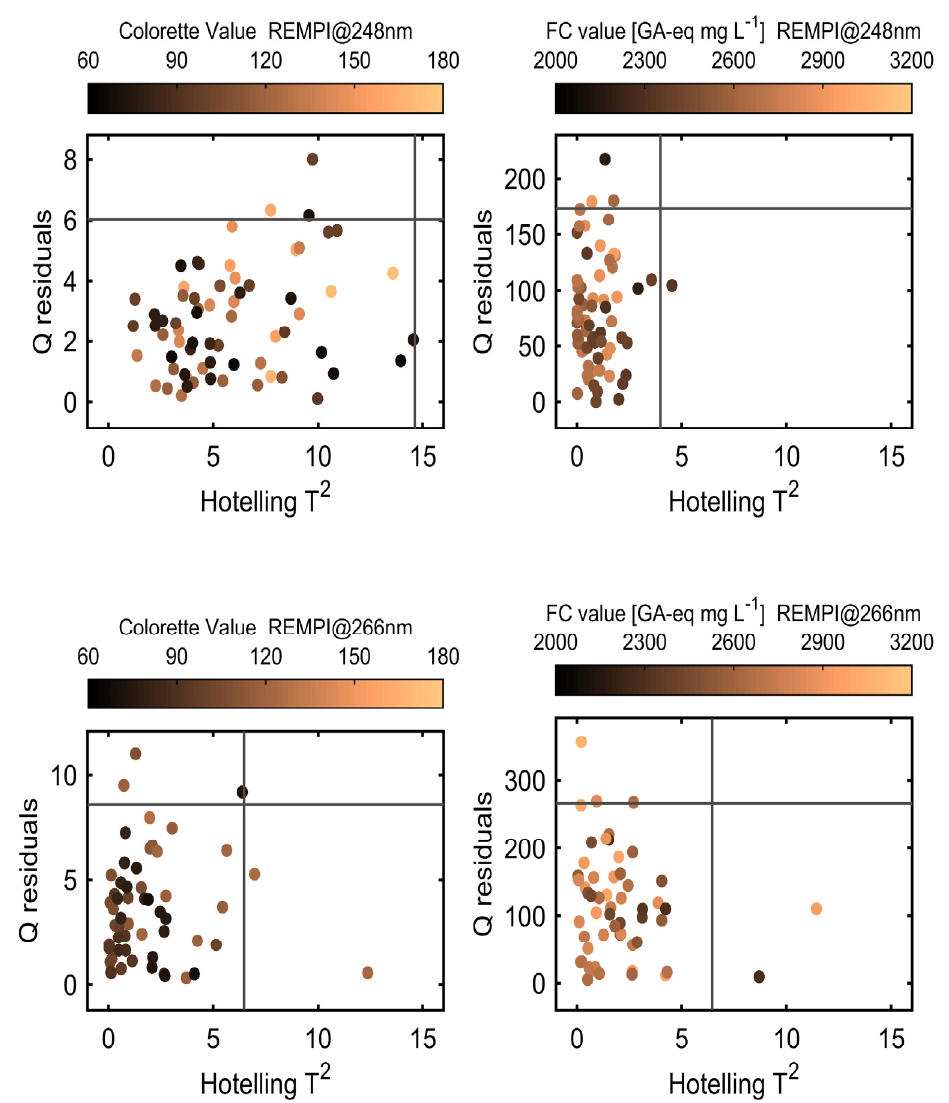
Figure A5. T 2 -Q diagnostic plots for outlier identification of samples in the calibration (training) data set. Larger Q appear for samples which are worse reproduced, while Hotelling’s T 2 represents the influence of an individual calibration sample on the model. Vertical and horizontal lines denotes the 95% confidence limits. A calibration sample is regarded as outlier if it appears both outside the confidence limits for Q and Hotelling’s T 2 .